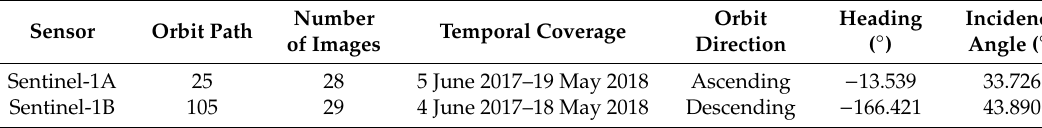
Table 1. Detailed parameters of the synthetic aperture radar (SAR)